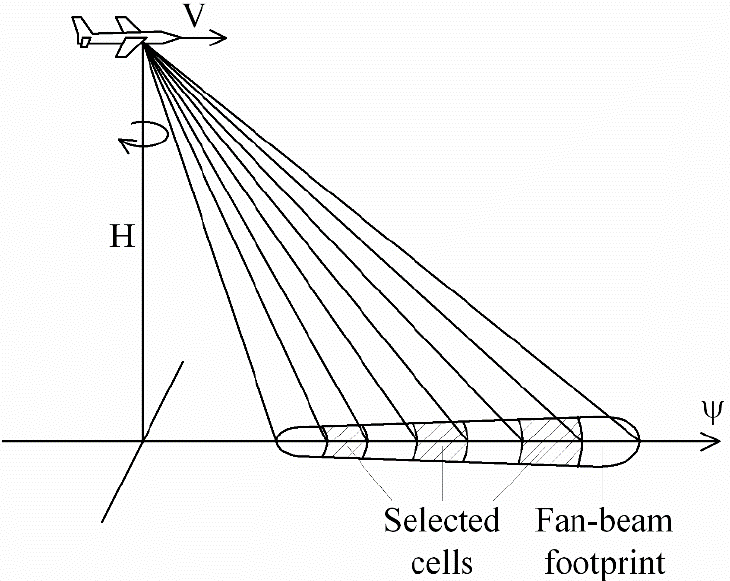
Figure 2. Rotating antenna fan-beam geometry (three selected sell case in the vertical plane): V is the speed of flight; H is the altitude; ψ is the aircraft flight direction.